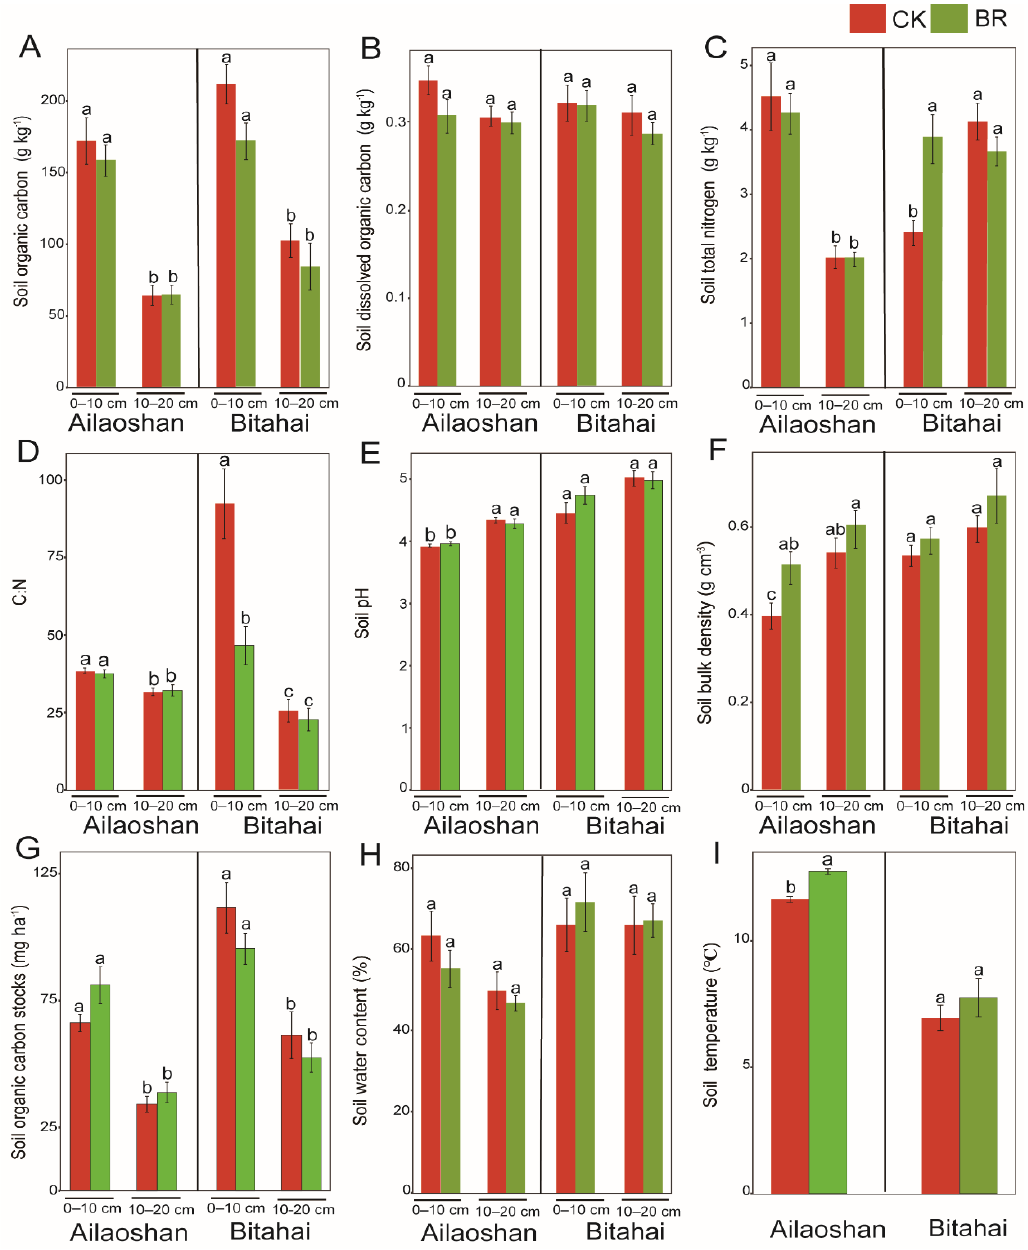
Figure 2. Effects of bryophyte removal (CK: no bryophyte removal; BR: (bryophytes removed) and soil depth (0–10 and 10–20 cm) on soil physicochemical properties in Ailaoshan and Bitahai. ( A ): soil organic carbon, ( B ): soil dissolved organic carbon, ( C ): soil total nitrogen, ( D ): soil organic carbon and total nitrogen, ( E ): soil pH, ( F ): soil bulk density, ( G ): soil organic carbon stocks, ( H ): soil water content, ( I ): soil temperature. Values are the means ± SE of six plots. Different lowercase letters mean significant differences at P < 0.05 between treatments.